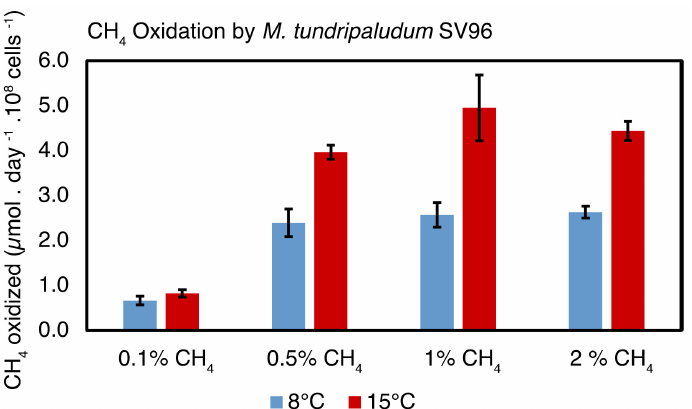
Figure 3. CH 4 oxidation per cell for Methylobacter tundripaludum SV96 at 8 ◦ C (blue) and 15 ◦ C (red) with CH 4 headspace concentrations ranging from 0.1% to 2%.